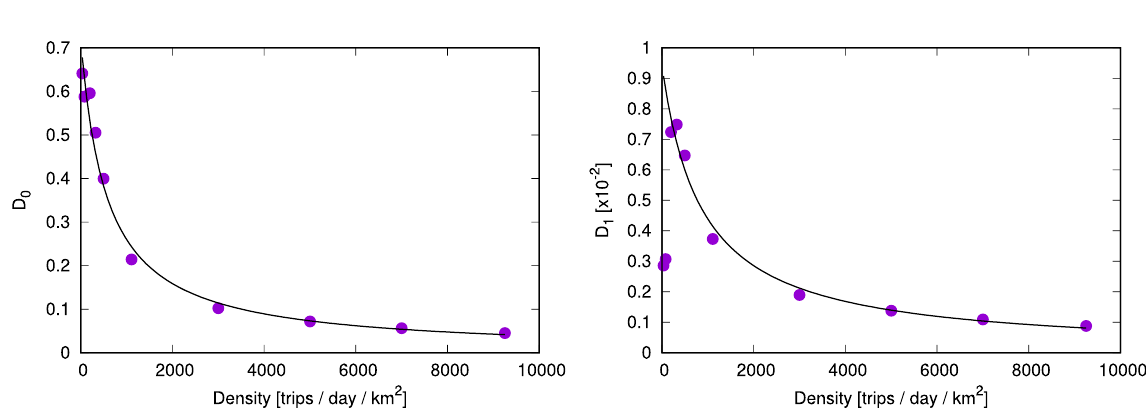
Figure 3. Coefficients D 0 and D 1 (left and right panel respectively) from the fitted lines in Fig. S4 in the SI as a function of trip